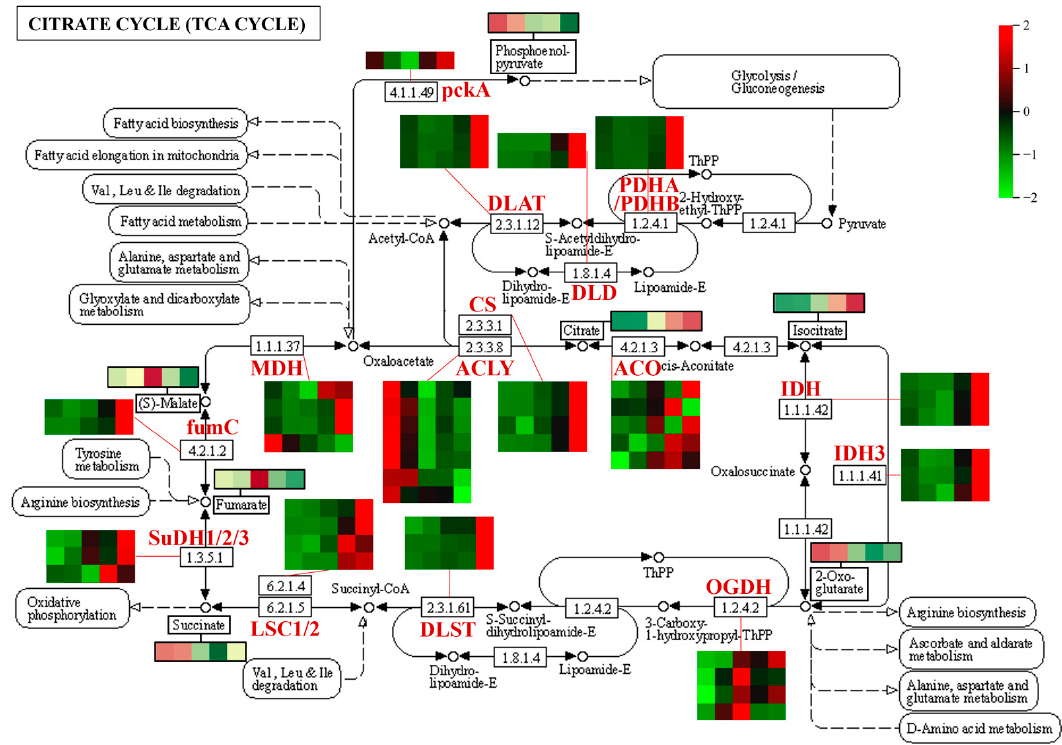
Figure 10. Expression patterns of differentially expressed genes (DEGs) associated with organic acid metabolism (TCA cycle) during hawthorn development. Enzyme classes in the metabolic pathway are indicated in red. Heat maps represent the expression patterns of DEGs involved in the metabolic pathway. On each heat map, rows represent different transcripts, and the five columns from left to right represent the five developmental periods (S1, S2, S3, S4, and S5: 30, 60, 90, 120, and 150 days after full-bloom, respectively). Changes in the contents of some metabolites (indicated by black boxes) during the five developmental periods of the fruit are indicated. MDH, malate dehydrogenase; CS, citrate synthase; ACLY, ATP citrate (pro-S)-lyase; ACO, aconitate hydratase; IDH1, isocitrate dehydrogenase; IDH3, isocitrate dehydrogenase (NAD+); OGDH, 2-oxoglutarate dehydrogenase E1 component; DLST, dihydrolipoamide succinyl transferase; LSC1, succinyl-CoA synthetase α subunit; LSC2, succinyl-CoA synthetase β subunit; SuDH1, succinate dehydrogenase (ubiquinone) flavoprotein subunit; SuDH2, succinate dehydrogenase (ubiquinone) iron-sulfur subunit; SuDH3, succinate dehydrogenase (ubiquinone) cytochrome b560 subunit; fumC, fumarate hydratase, class II; DLD, dihydrolipoamide dehydrogenase; pckA, phosphoenolpyruvate carboxykinase (ATP); DLAT, pyruvate dehydrogenase E2 component (dihydrolipoamide acetyltransferase); PDHA, pyruvate dehy- drogenase E1 component α subunit; and PDHB, pyruvate dehydrogenase E1 component β subunit. Additionally, p-coumaroyl-CoA is involved in the formation of some phenolic acids and plays roles in various metabolic pathways (e.g., flavonoid biosynthesis and phenyl- propanoid biosynthesis). As shown in Figure 11, the formation of chlorogenic acid is associated with C3 (cid:48) H (5-O-(4-coumaroyl)-D-quinate 3 (cid:48) -monooxygenase gene), and the amount of chlorogenic acid in hawthorn fruit is positively correlated with the expression level of the C3 (cid:48) H